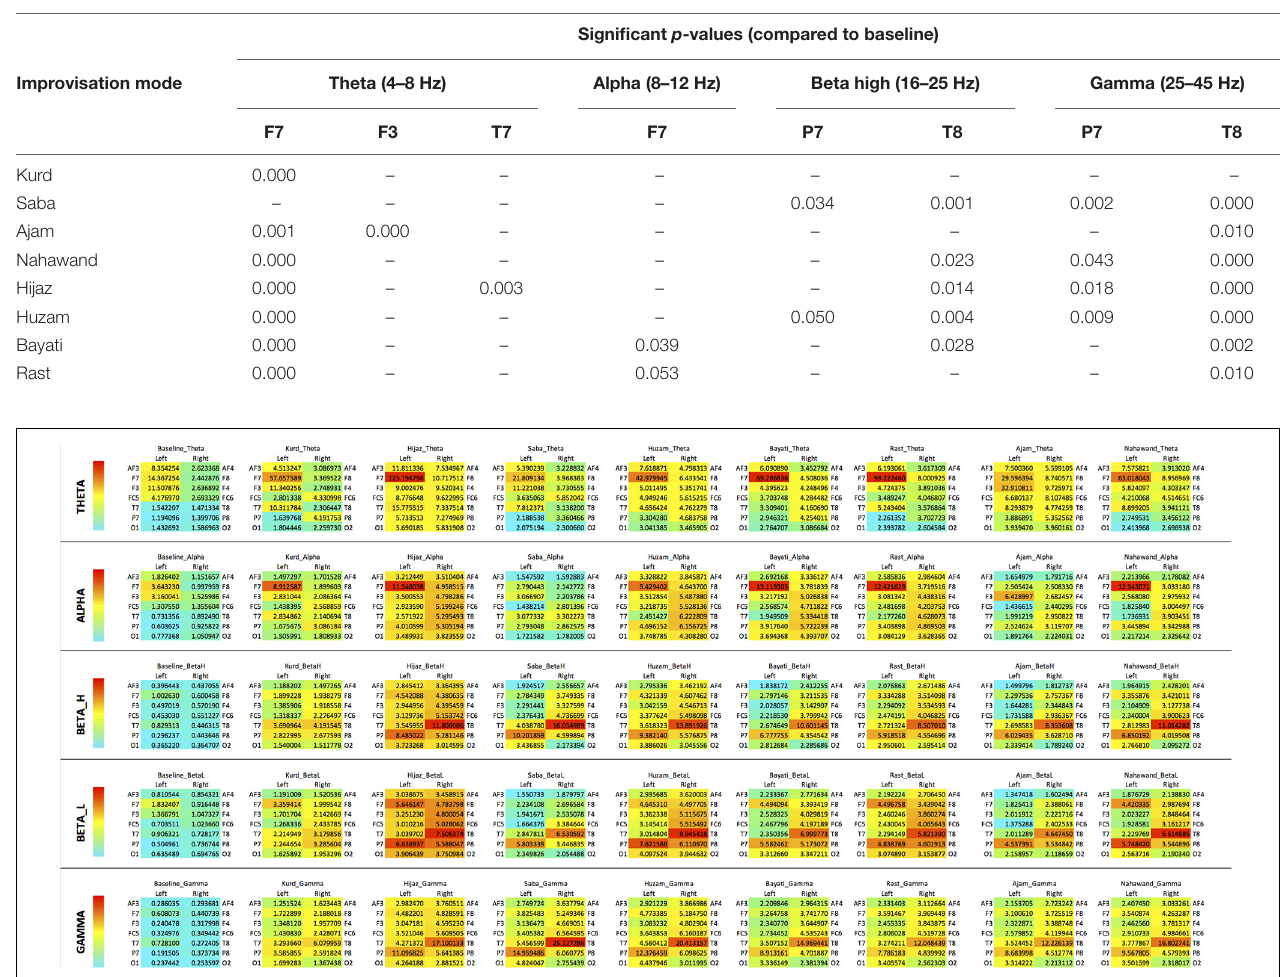
FIGURE 3 | Heatmaps of power spectra of frequency bands at 14 electrode sites for each maqam . Heatmap were computed for each frequency band type across all maqams. Power spectra are organized in a way to simulate scalp map (frontal on top, occipital on bottom, left, and right